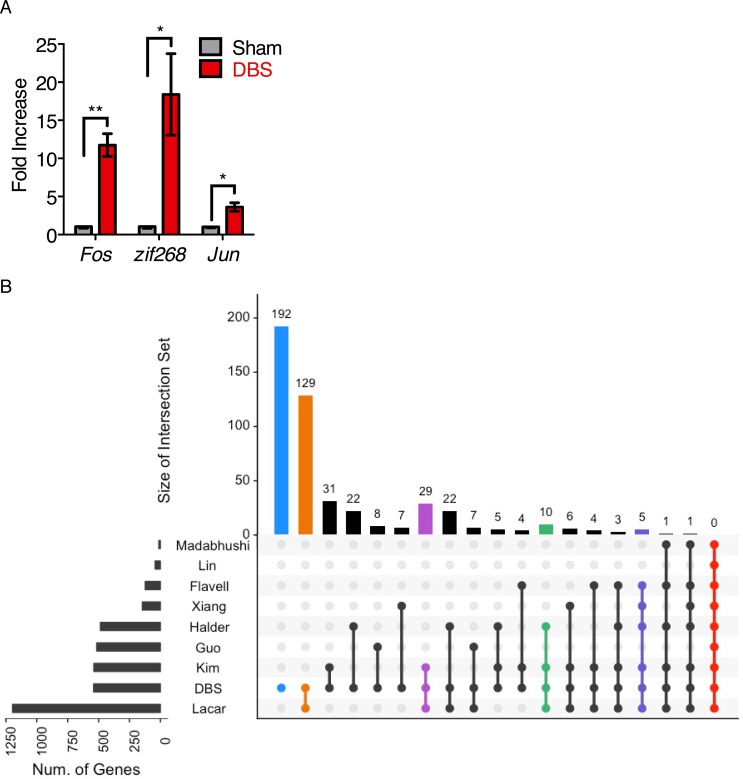
Determining stimulation duration for acute DBS and overlap of DBS-induced genes with previously reported activity-dependent genes.(A) RT-qPCR evaluation of the expression of 3 activity-dependent genes in DG tissue from WT mice following 45 min of DBS with a 20 min post-stimulation recovery period (n = 4 DBS, three sham; error bars: SEM; unpaired, two-tailed t-test; *p<0.05; **p<0.01; normalized to GAPDH). (B) Overlap of genes previously reported to be activity-dependent with those genes found to be significantly upregulated (FDR < 0.05, fold-change >2) by forniceal DBS in WT mice.